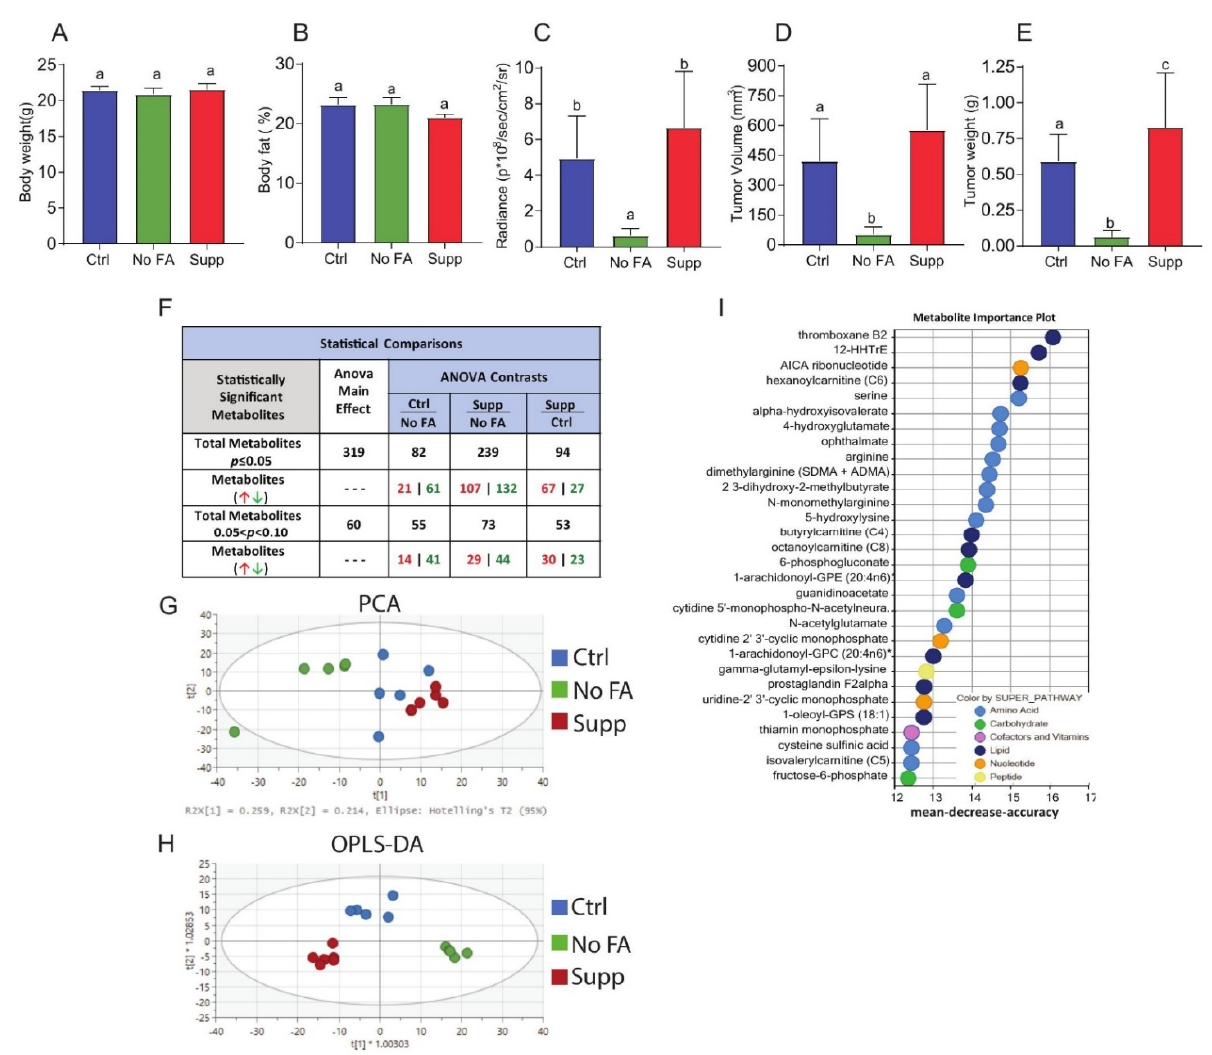
Figure 1. Dietary folate restriction inhibits growth of MDA-MB-231 tumors and alters metabolomic profiles. Body weight ( A ) and body fat% ( B ) of mice fed control (Ctrl, 2 ppm FA), FA-deficient (No FA, 0 ppm FA) or FA-supplemented (Supp, 12 ppm FA) diets (n = 12–14/group). IVIS bioluminescence imaging of luciferase-labelled MDA-MB-231 tumors ( C ) (n = 13–14/group). Ex vivo volume ( D ) and weight ( E ) of MDA-MB-231 tumors at the endpoint of the